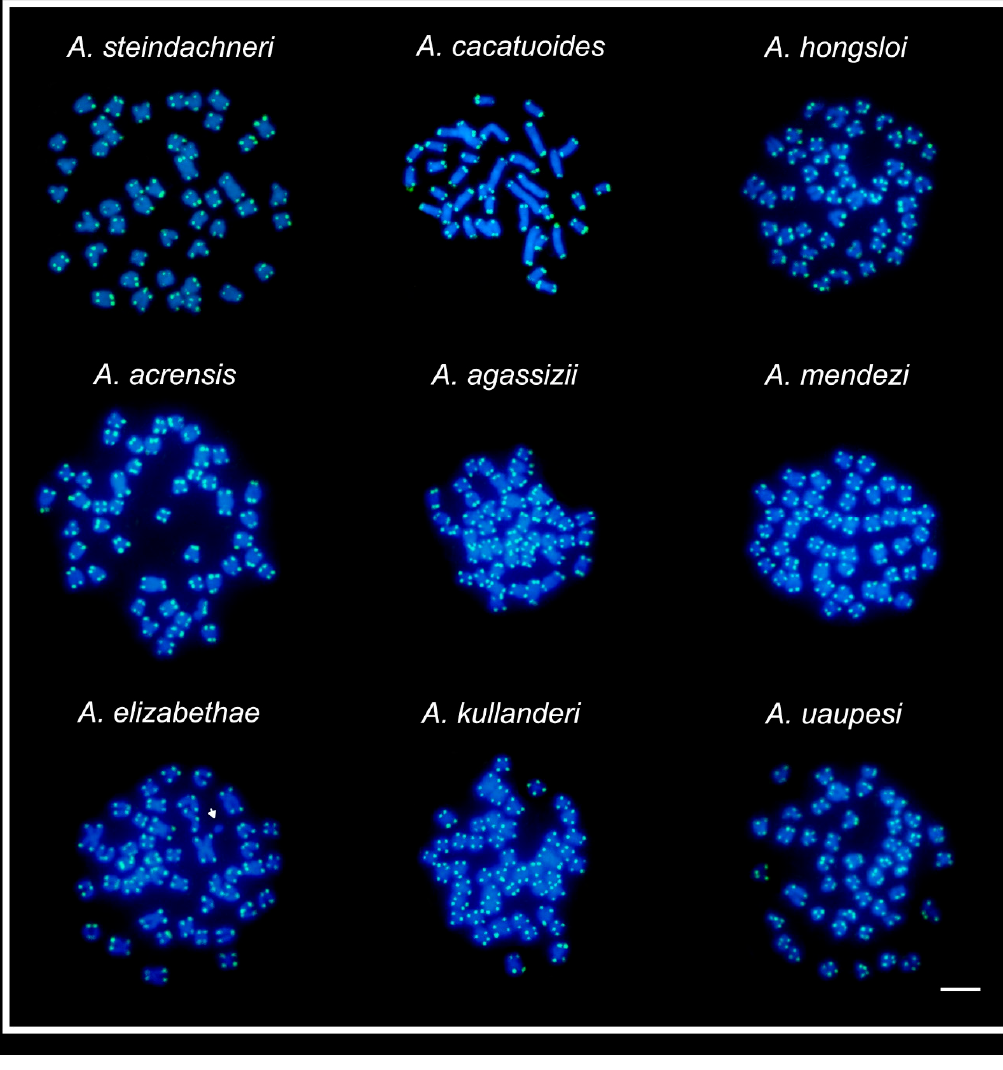
Figure 4. In situ hybridization with telomeric probe (TTAGGG) n in somatic metaphases of nine Apistogramma species. The arrow shows B-chromosome in Apistogramma elizabethae complement without hybridization signals. Bar = 5 μ m.